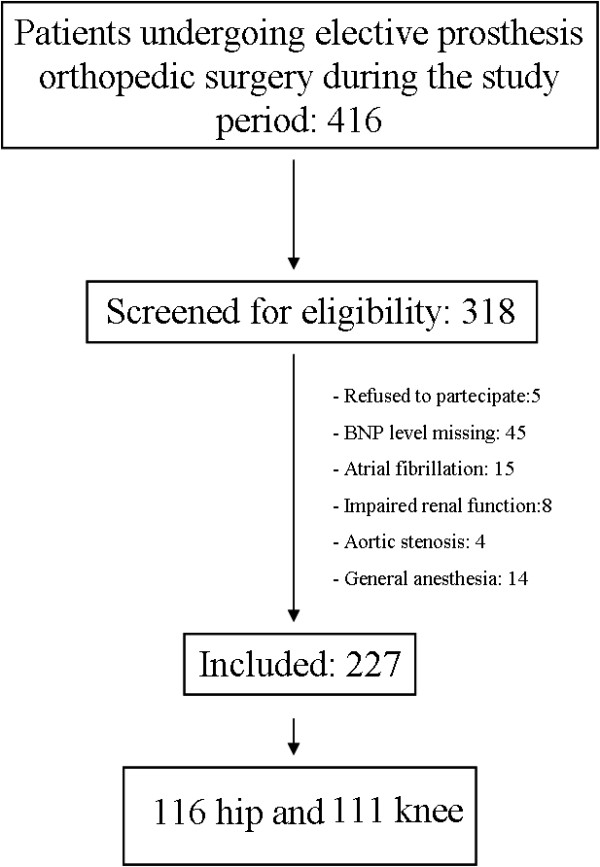
Diagram of the patient flow through the study.